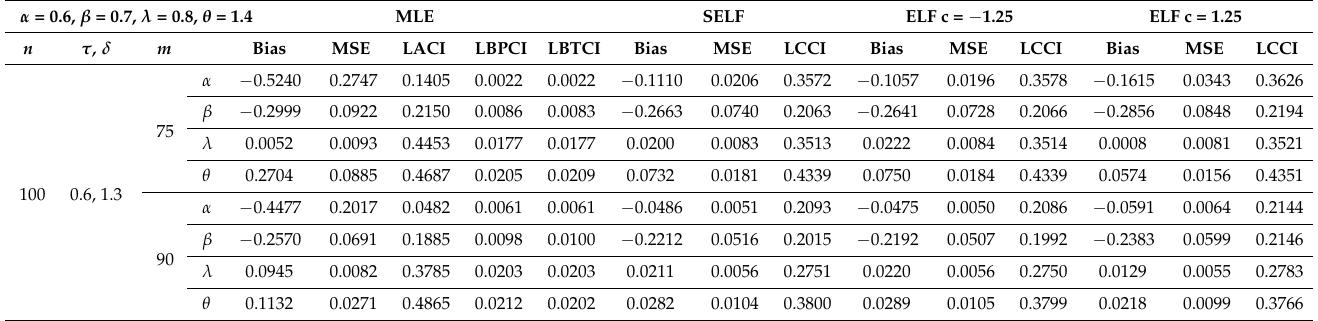
Table 4. Bias, MSE, LACI, LBCI, and LCCI with scheme 1 in case